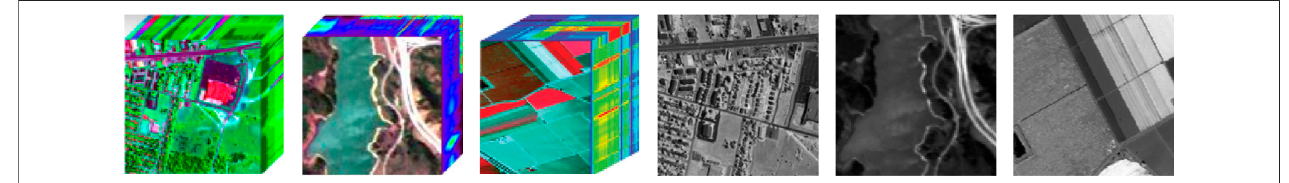
FIGURE 6 | Hyperspectral images used in experiments. (A) Urban, (B) Jasper Ridge, (C) Salinas, (E) 90th band of Urban, (F) 30th band of Jasper Ridge, and (G) 40th band of Salinas.